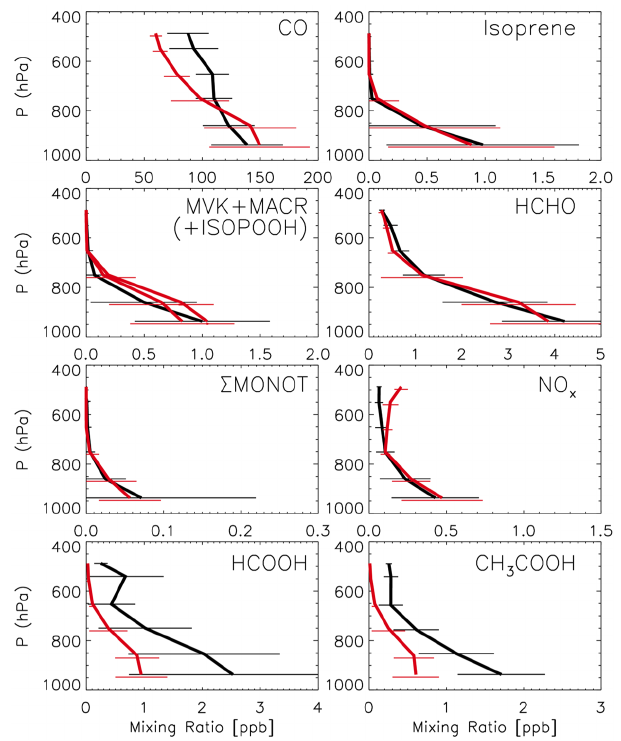
Figure 3. Vertical profiles of HCOOH and related species during summer over the US Southeast. Measurements from the SENEX campaign are plotted in black, and are compared to simulated con- centrations from GEOS-Chem (in red) sampled along the flight track at the time of measurement. Horizontal lines show the stan- dard deviation of concentration in each altitude bin. Fresh biomass burning (CH 3 CN > 225ppt) and pollution (NO x / NO y > 0.4 or NO 2 > 4ppb) plumes have been removed prior to plotting. Sepa- rate lines are shown for the simulated abundance of MVK + MACR and MVK + MACR plus isoprene hydroxyhydroperoxides (a.k.a. ISOPOOH), which can interfere with MVK + MACR measurements (Liu et al., 2013).